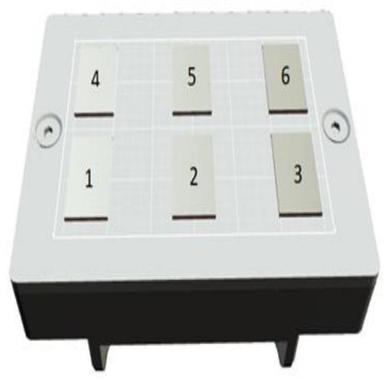
Arrangement of samples for dimensional accuracy experiments. Numbers on samples represent printing zones 1 to 6 on the build head.